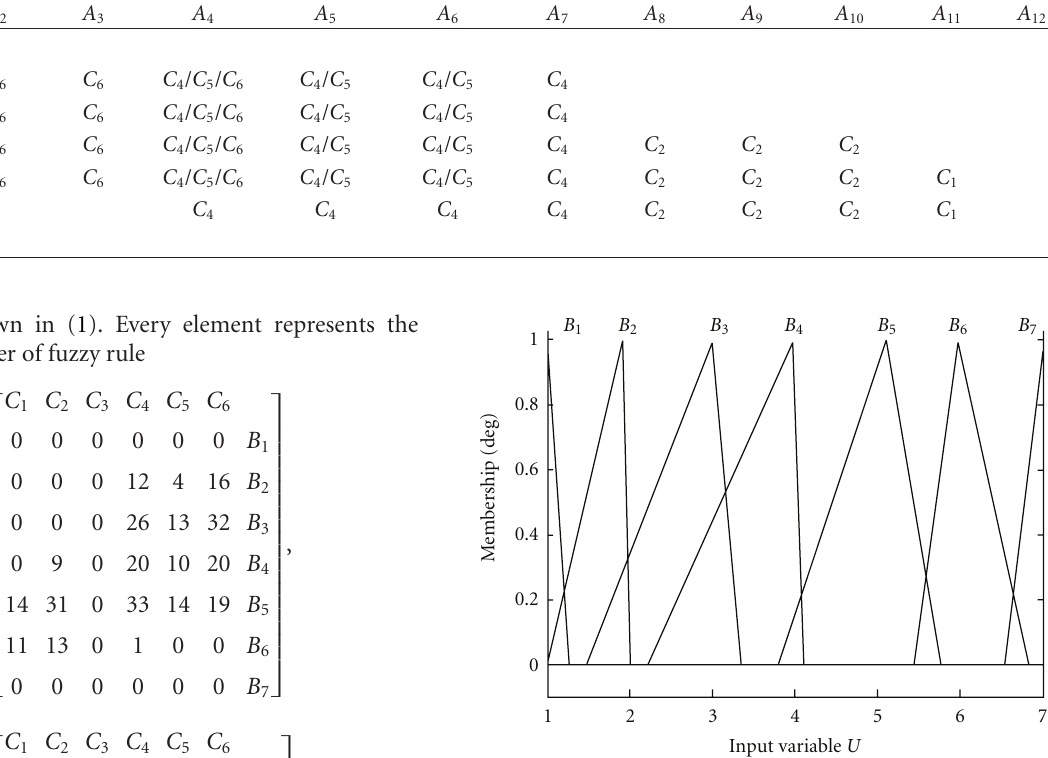
Figure 4: Membership functions of U